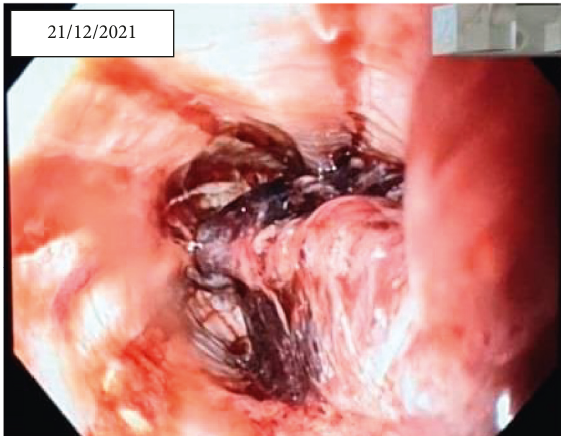
Figure 4: Endoscopic view of esophageal lumen demonstrating extensive mural hemorrhage with clot formation, intraluminal bulging, and significant narrowing (date performed: December 21, 2021)